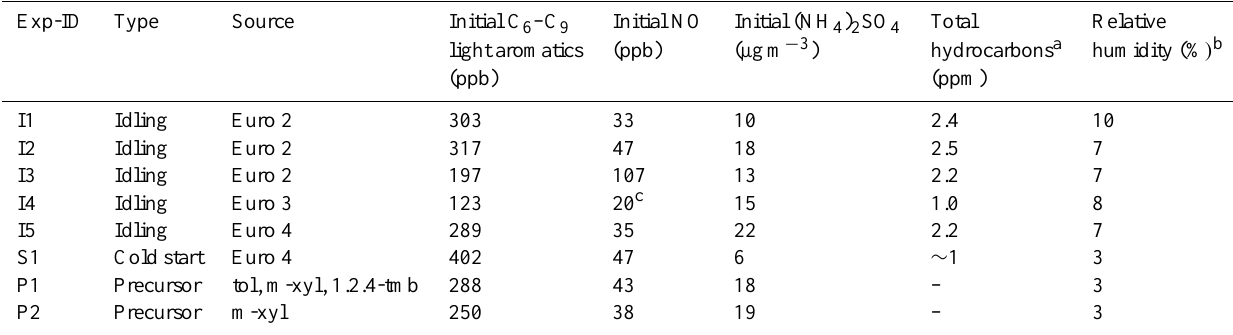
Table 1. Initial experimental conditions.